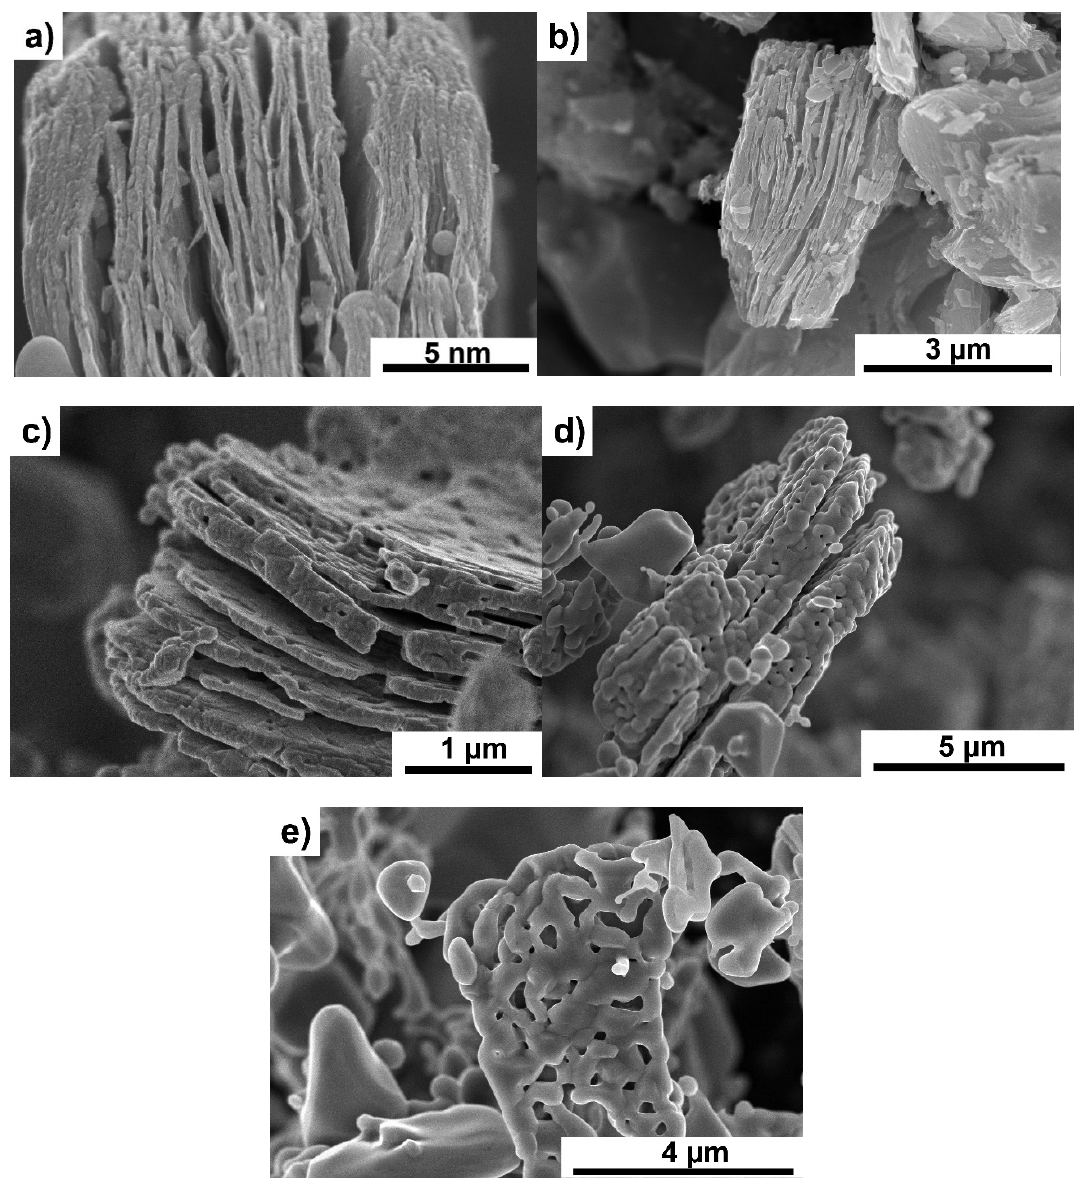
Figure 2. Morphology of Ti 3 C 2 MXene powders annealed in vacuum at temperatures of ( a ) 1000 °C, ( b ) 1200 °C, ( c ) 1400 °C, ( d ) 1600 °C and ( e ) 1800 °C .